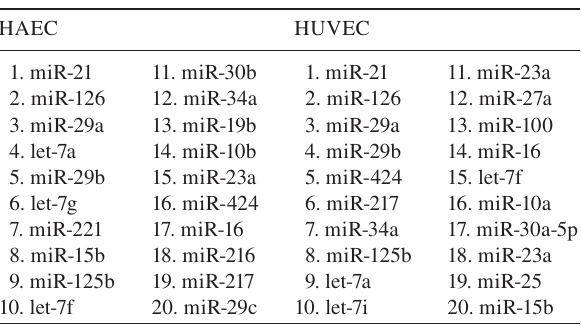
Total RNAs were extracted from HAECs and HUVECs and frac- tionated by size exclusion column chromatography and gel extrac- tion. Small RNA (15 – 30 nt) were cloned into cloning vectors and sequenced. The number of miRNA was counted and ordered from the highest number of miRNAs. Data represent the top 20 miRNAs that are highly expressed in HAEC and